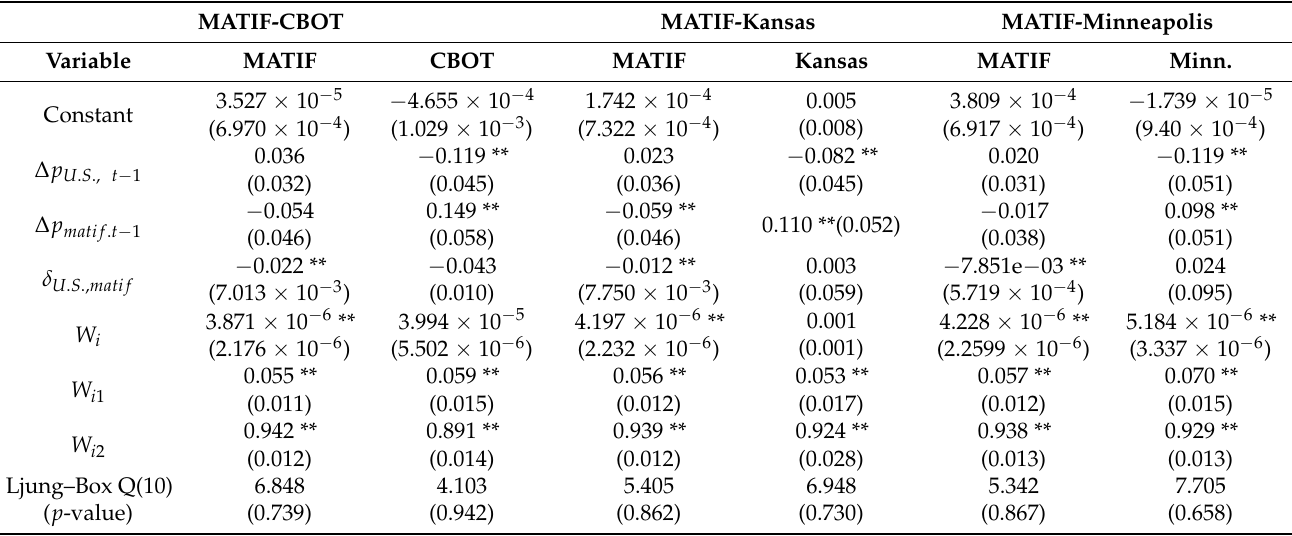
Table 5. Results for the univariate error-correction type of model and generalized autoregressive conditional heteroskedas- ticity (ECM-GARCH) (1,1) model for the first